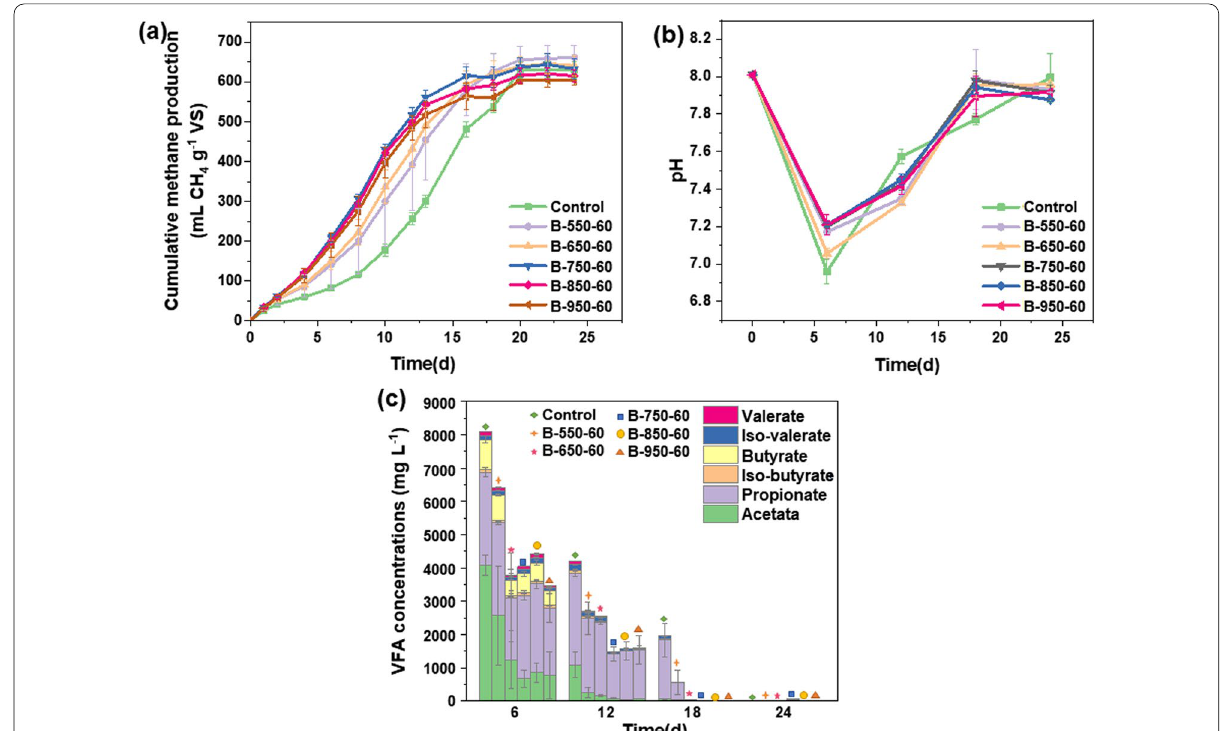
Fig. 2 Effect of biochar prepared at different pyrolysis temperatures on methane production: a cumulative methane production; b pH variation; c VFA concentrations